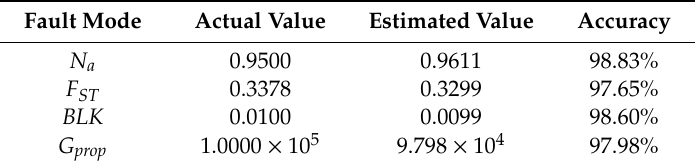
Table 3. FDI results for a low-level damage combination.